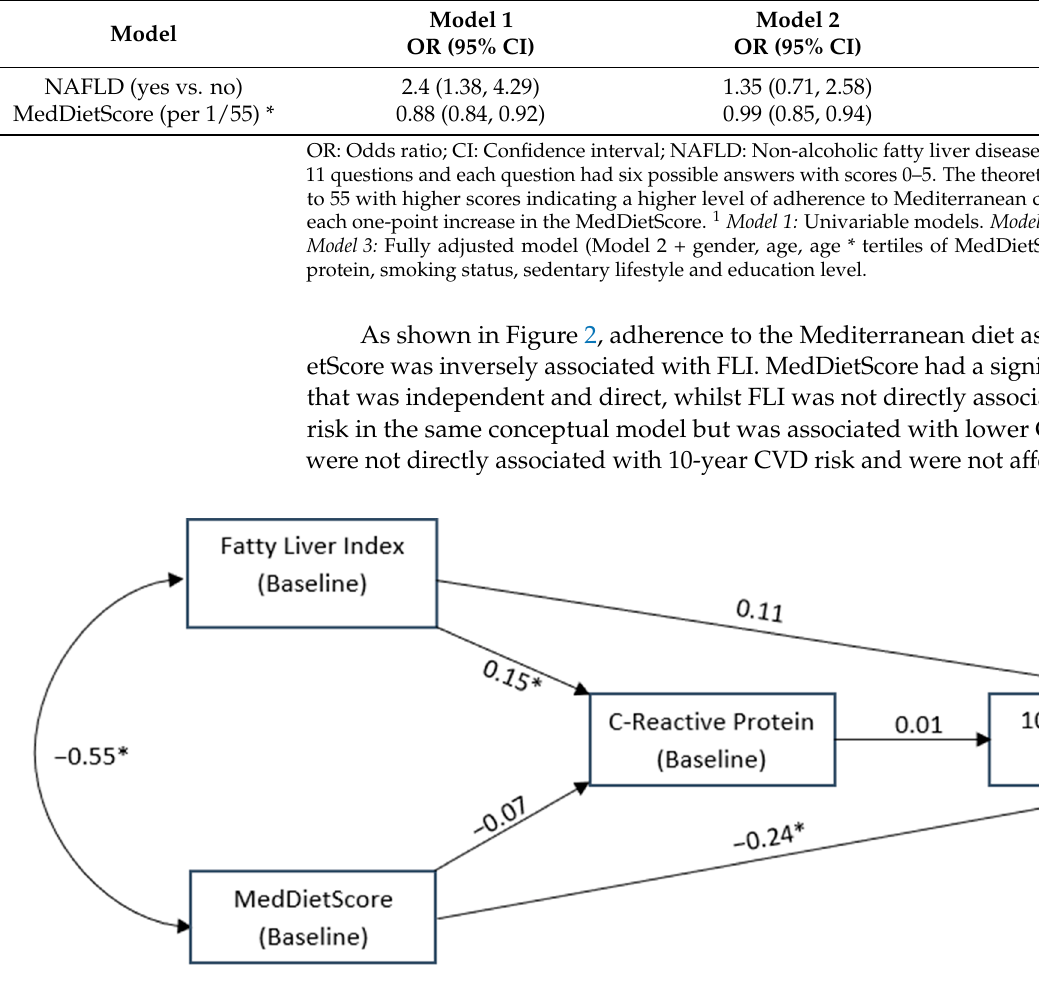
Figure 2. Structural equation model conceptualising the potential mediating role of C-Reactive protein levels on the association between fatty liver index, MedDietScore at baseline and the 10-year CVD risk. * is indicated where the relationship was statistically significant .